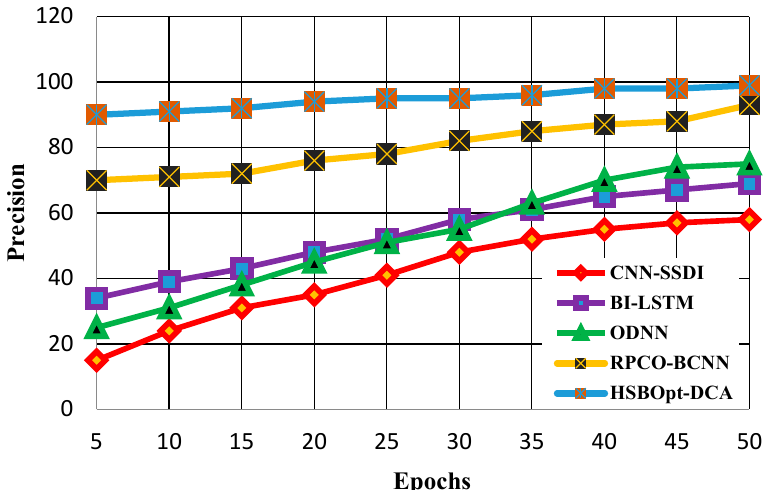
Figure 5. Precision calculation with 50 epochs.